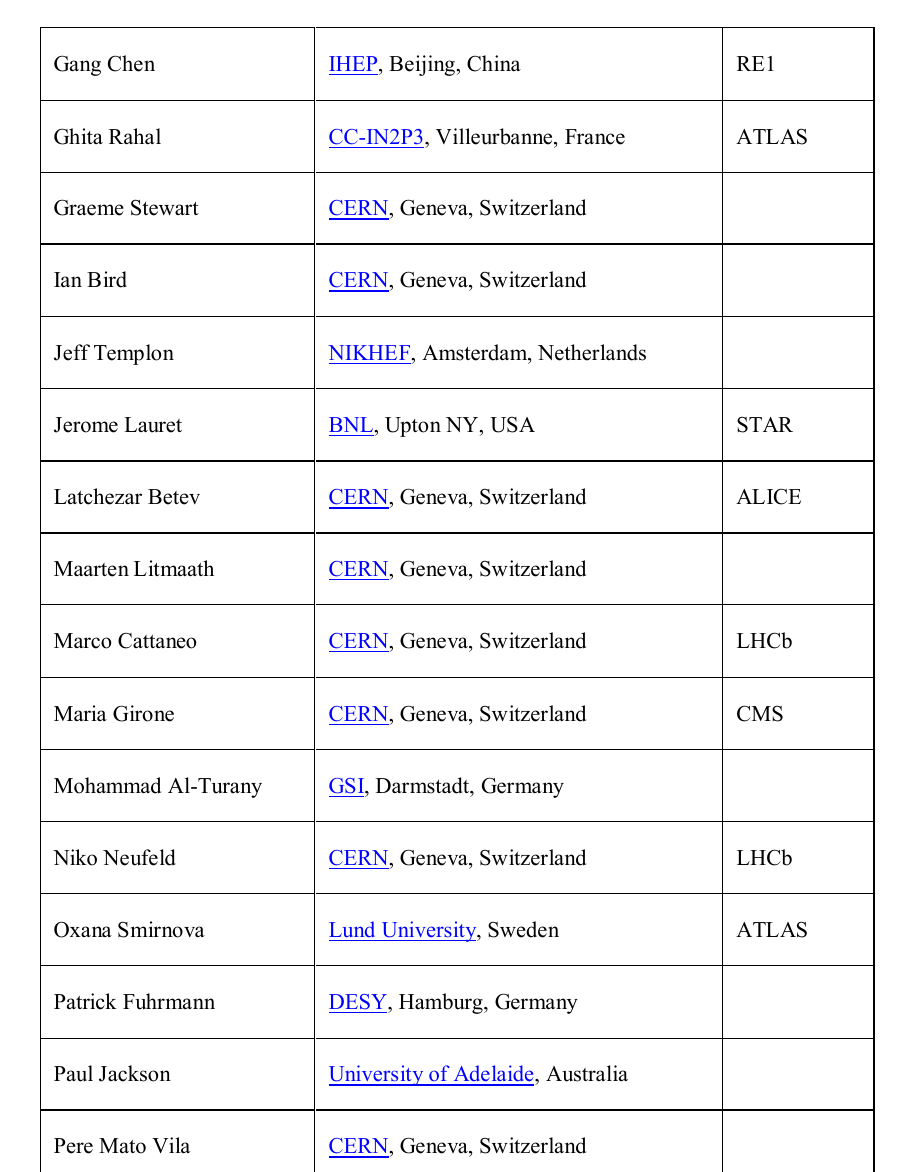
Table 3. Members of the International Advisory